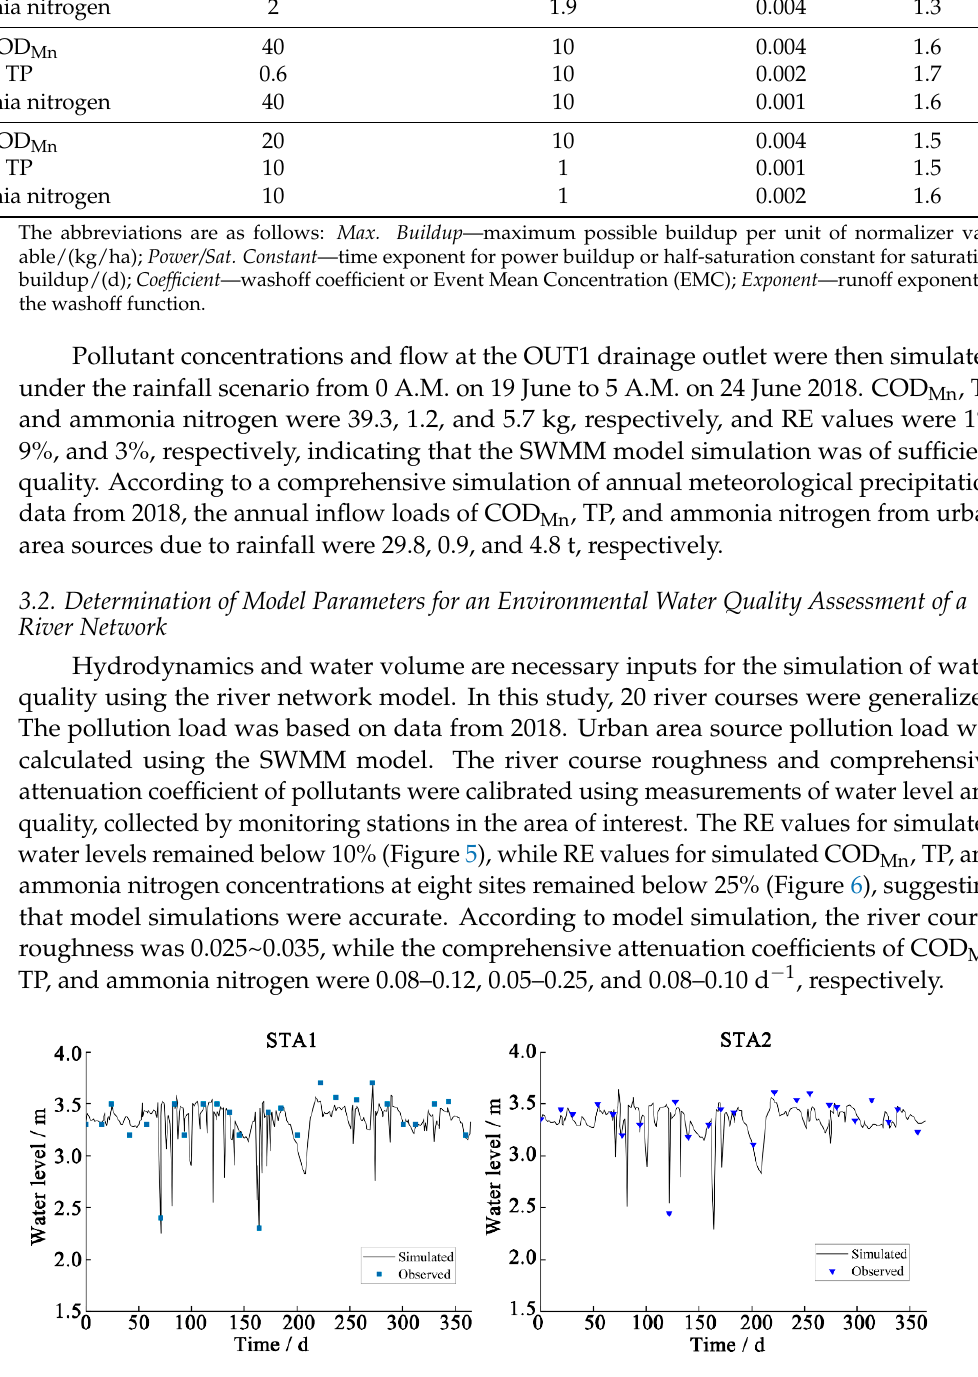
Figure 6. Water quality calibration results at STA1 ( a – c ) and STA2 ( d – f ) of the MIKE11 model. 3.3. Relationship between Urban Area Source Pollution and Water Environment Quality Haimen River, a typical plain channel in China’s Yangtze River Delta that runs through the central urban area, was used for the next set of simulations. Three distinct rainfall events were selected: light rain, moderate rain, and heavy rain. Water quality changes at the OUT1 drainage outlet of a pipeline network into an estuary were simulated under various rainfall scenarios. Under the rainfall scenario from 2 P.M. on 25 March to 4 P.M. on 26 March 2018, total rainfall duration was 12 h and total precipitation was 5 mm, which corresponds to light rain (Figure 7a–c). There was a time lag between the start of the rainfall event and the change in pollutant concentrations. COD Mn , TP, and ammonia nitrogen continued to climb significantly after precipitation stopped, with values peaking after 8 h at a maximum COD Mn concentration of 9.02 mg/L. The concentration of TP was 0.24 mg/L, while that of ammonia nitrogen was 0.46 mg/L. Sixteen hours after precipitation, TP and ammonia- nitrogen concentrations steadily fell to pre-rainfall levels. In the subsequent 4 h, the con- centration of COD Mn returned to pre-rainfall levels. The total duration of the effect of rain- fall was 24 h. Under the rainfall scenario between 4 P.M. on 16 July to 8 P.M. on 18 July 2018, the total rainfall duration was 52 h and the total precipitation was 23.5 mm, which corre- sponds to moderate rain. As depicted in Figure 7d–f, there was a time lag between the start of the rainfall event and the change in pollutant concentrations, similar to that ob- served in the light rain scenario. As rainfall continued, pollutant concentrations increased and peaked 40 h after the onset of rainfall, with a COD Mn concentration of 11.76 mg/L, a TP concentration of 1.89 mg/L, and an ammonia nitrogen concentration of 8.78 mg/L. Val- ues returned to their pre-rainfall levels after 52 h. The rainfall event no longer influenced